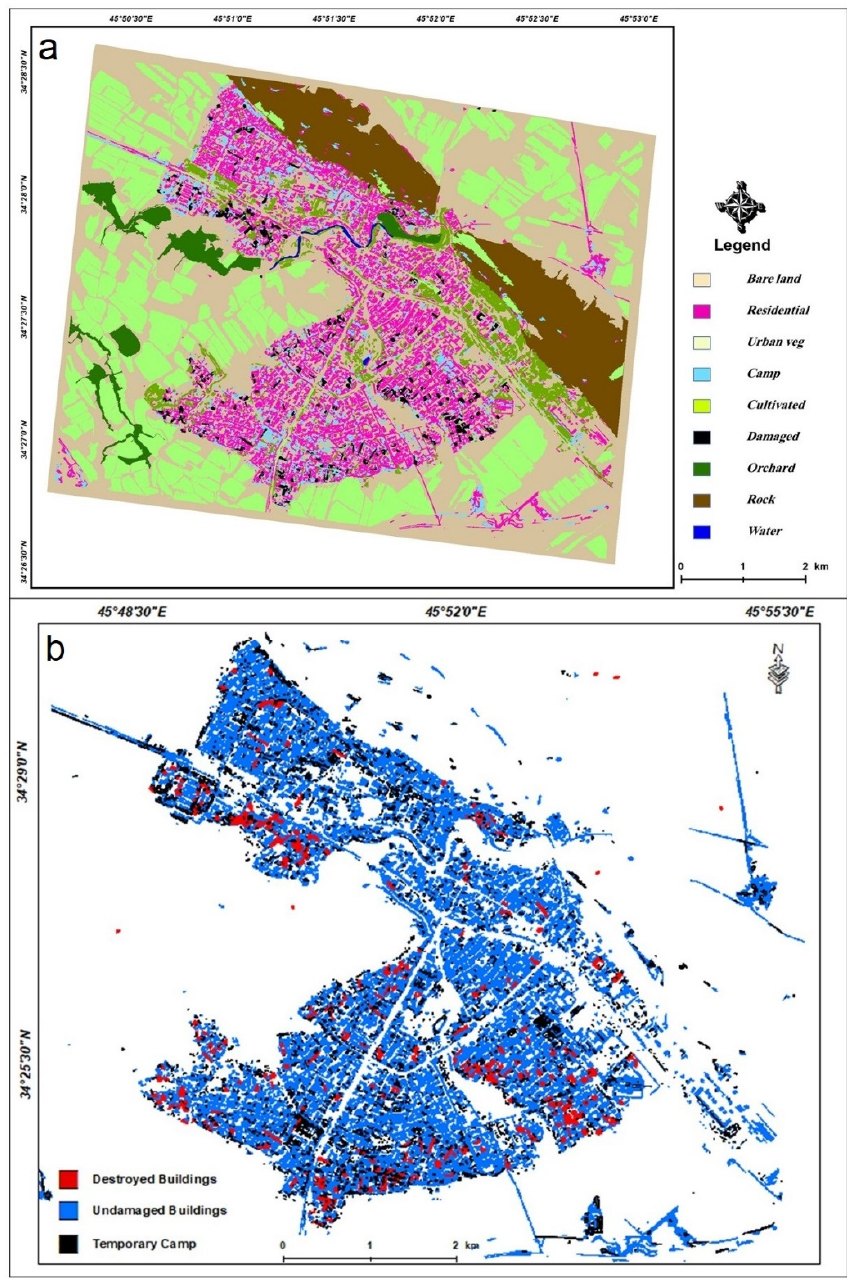
Figure 8. LULC map of Sarpol-e Zahab. ( a ): Whole extracted class map; ( b ): three main classes, namely, temporary camps, destroyed buildings, and undestroyed buildings.